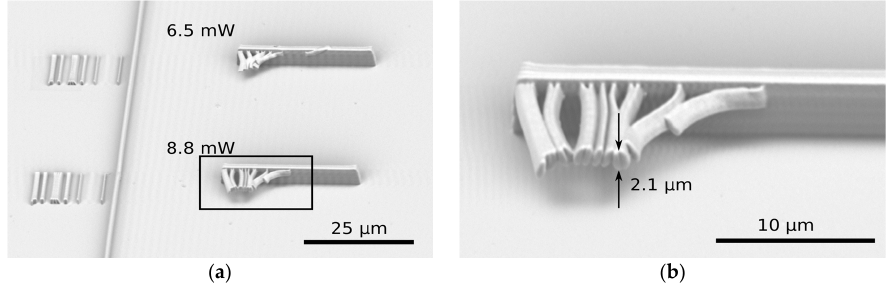
Figure 4. Writing tests for the rod dimensions and resolution evaluation for PR-40 and a writing speed of 90 µm/s. In ( b ) the zoomed image of the squared detail in image ( a ) can be observed.